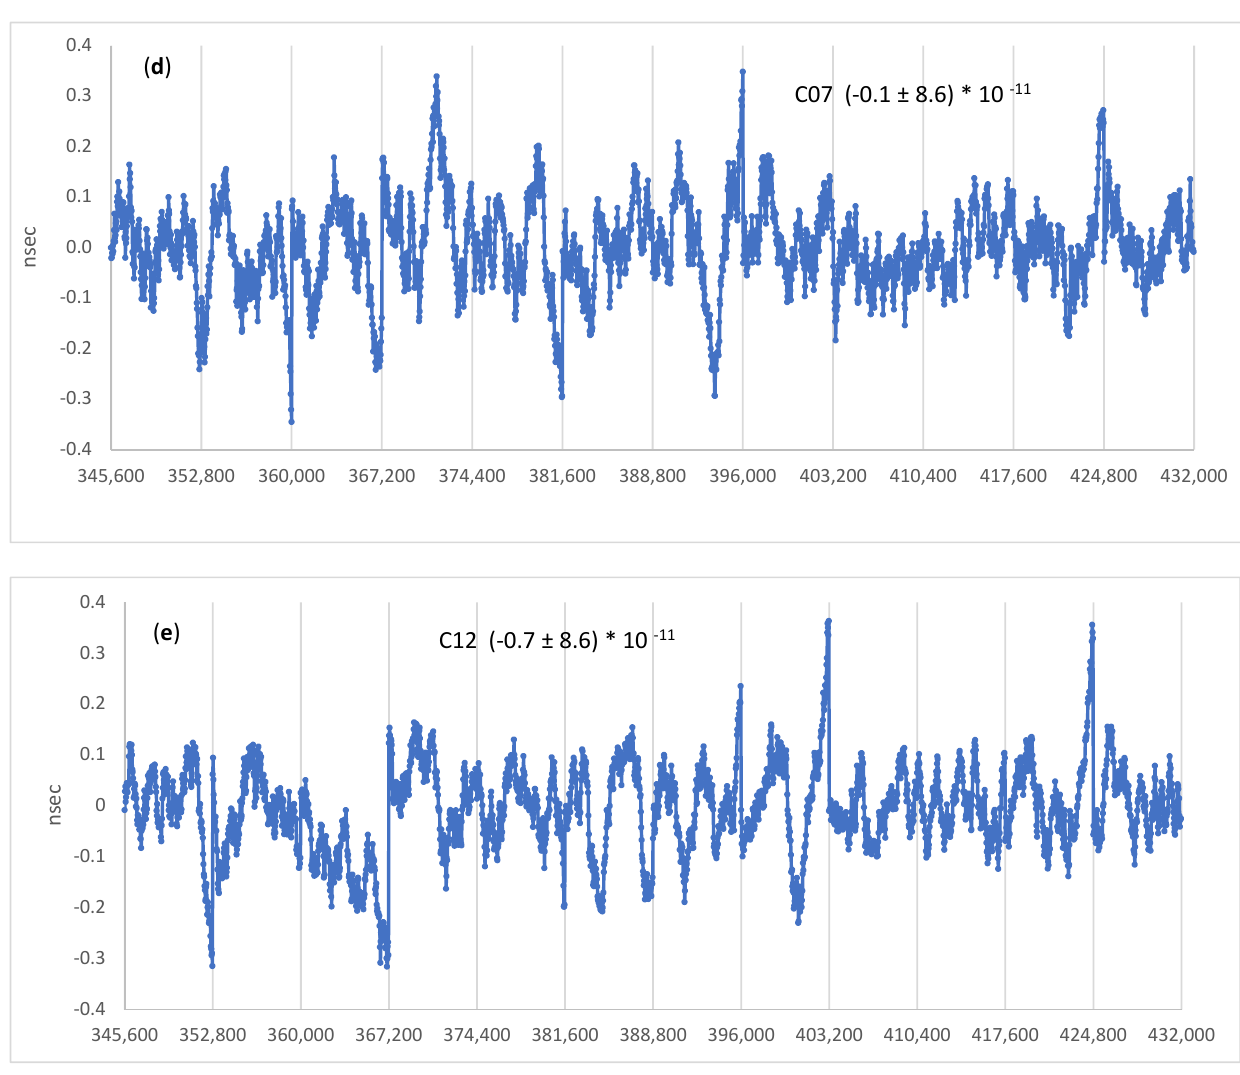
Figure 13. Plots of the differences between IGS high rate clocks and the prediction of our clock polynomials based on 15 min sampling. Update rate of the clock polynomials are 2 h for ( a ) G01, ( b ) E01, ( c ) 1 h for R01, ( d ) C07, and ( e ) C12. The mean and rms of the residuals are provided for each satellite.